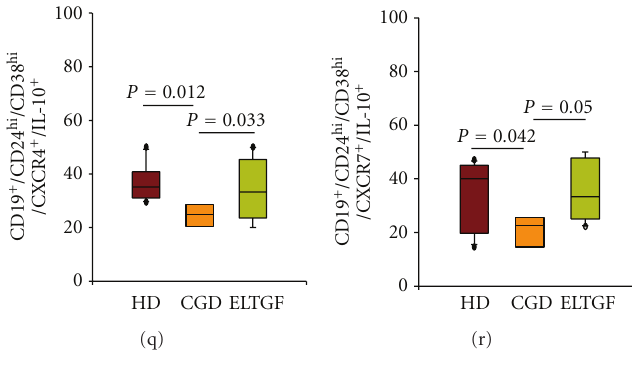
Figure 3: Percentage of immature/transitional IL-10-producing B peripheral cell subtype in KTR. (a) Representative contour plot of CD19 + B cells from a patient. An electronic gate was made for CD38 hi cells. (b) From the gate a CD19 + CD38 hi CD24 hi cells were determined. (c) From the gate b CD19 + /CD38 hi /CD24 hi /CD5 + were defined and an electronic gate was made for positive cells. From the latter CD19 + /CD38 hi /CD24 hi /CD5 + /IL-10 + cells were determined in (d) a healthy donor (HD), (e) a chronic graft dysfunction (CGD) patient, and (f) an excellent long-term graft function under immunosuppression (ELTGF) patient. (g) Percentage of homing receptor-expressing Breg subtype in KTR. An electronic gate was made for CD38 hi cells. (h) From the gate g CD19 + /CD38 hi /CD24 hi cells were determined. (i) From the gate h CD19 + /CD38 hi /CD24 hi /CXCR7 + were defined. From the latter CD19 + /CD38 hi /CD24 hi /CXCR7 + /IL-10 + cells were determined in (j) a HD, (k) a CGD, and (l) an ELTGF. Bar graphs show percentage of (m) CD5 + , (n) CD10 + , (o) CD20 + , (p) CD27 + , (q) CXCR4 + , and (r) CD19 + /CD38 hi /CD24 hi /CXCR7 + /IL-10 + -producing B peripheral cells. A total of 30,000–50,000 events were recorded for each sample before any gate setting and analyzed with the CellQuest Pro software (BD Biosciences). Results are expressed as median, 10th, 25th, 75th, and 90th